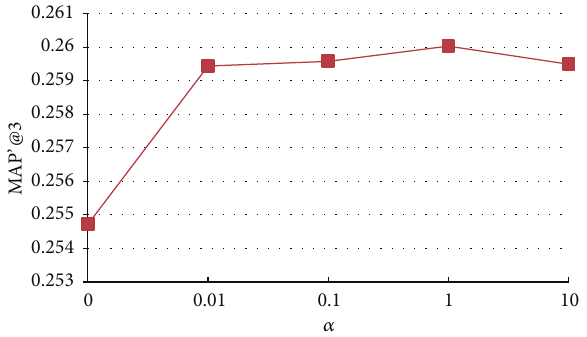
Figure 3: Impact of parameter 𝛼 on accuracy of Seeker source tran model .